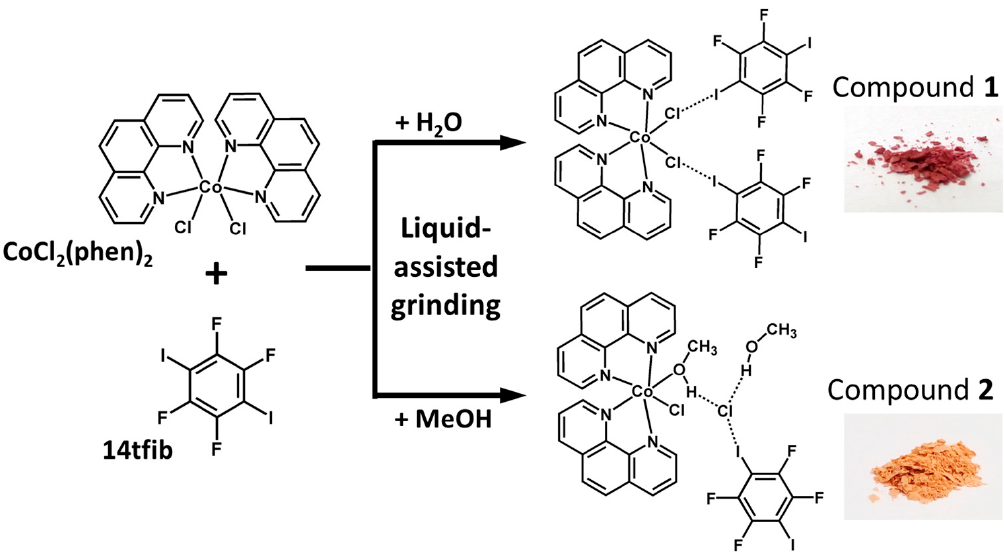
Figure 1. Mechanochemical synthesis of a halogen-bonded metal–organic structures: diagrams of 14tfib and the CoCl 2 ( phen ) 2 complex, and fragments of crystal structures of the resulting halogen-bonded metal–organic solids.